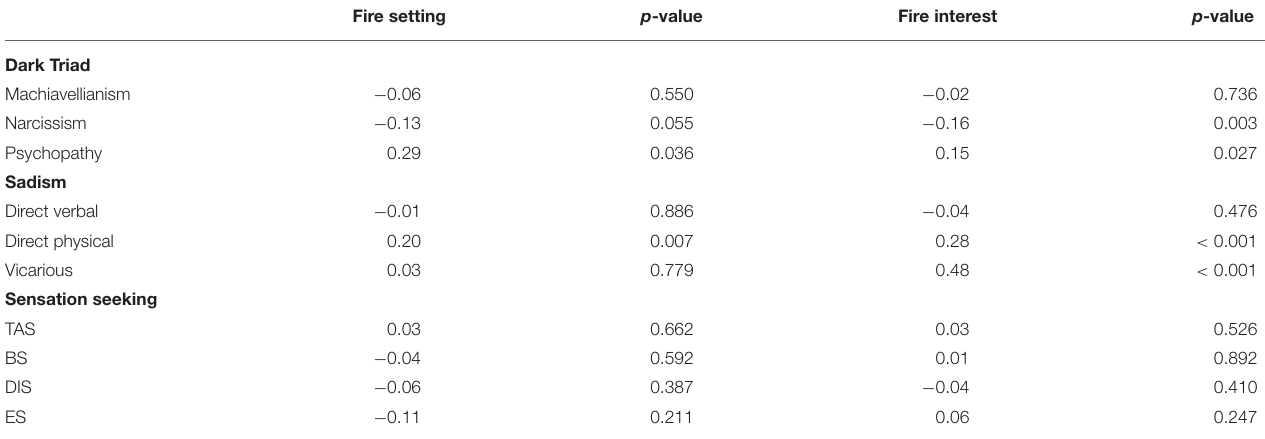
TABLE 2 | Standardized estimates from path models.